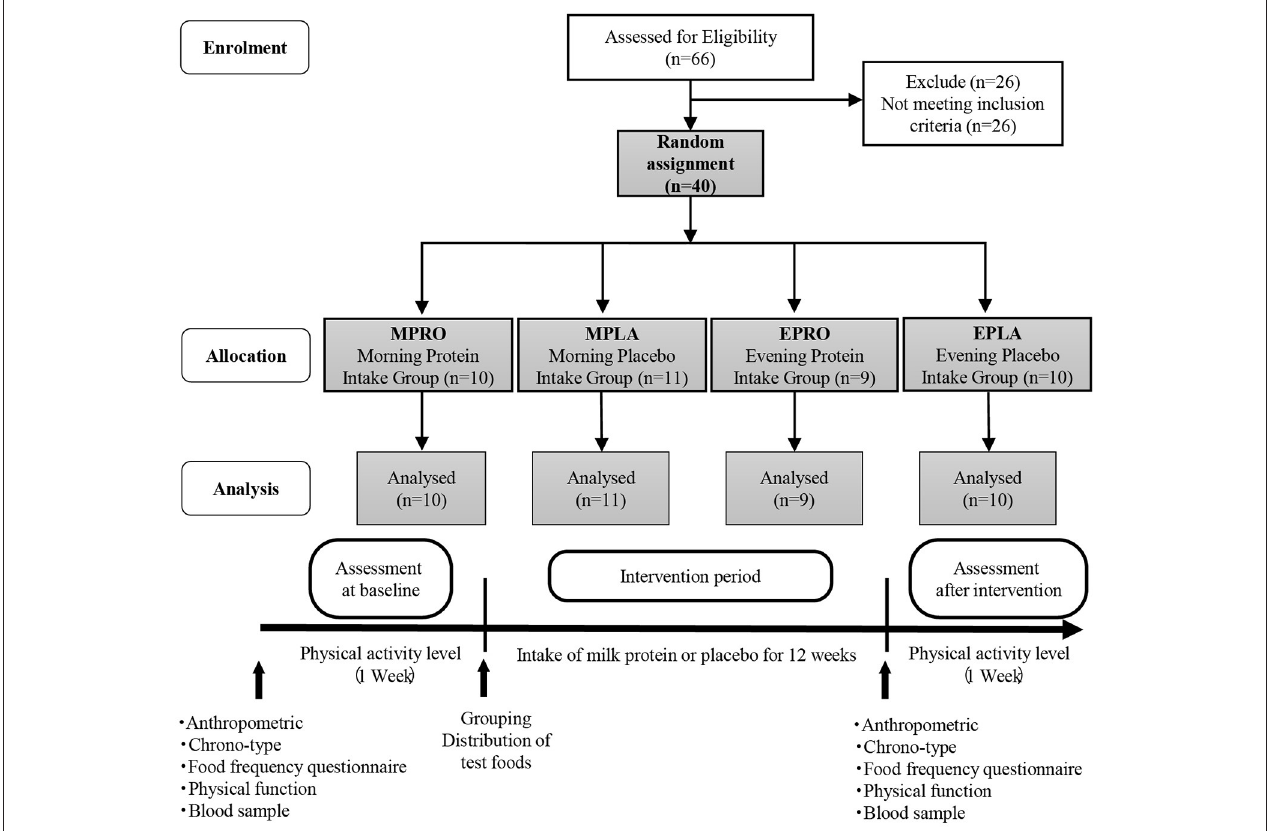
FIGURE 2 | Flow diagram showing the design of the intervention study and